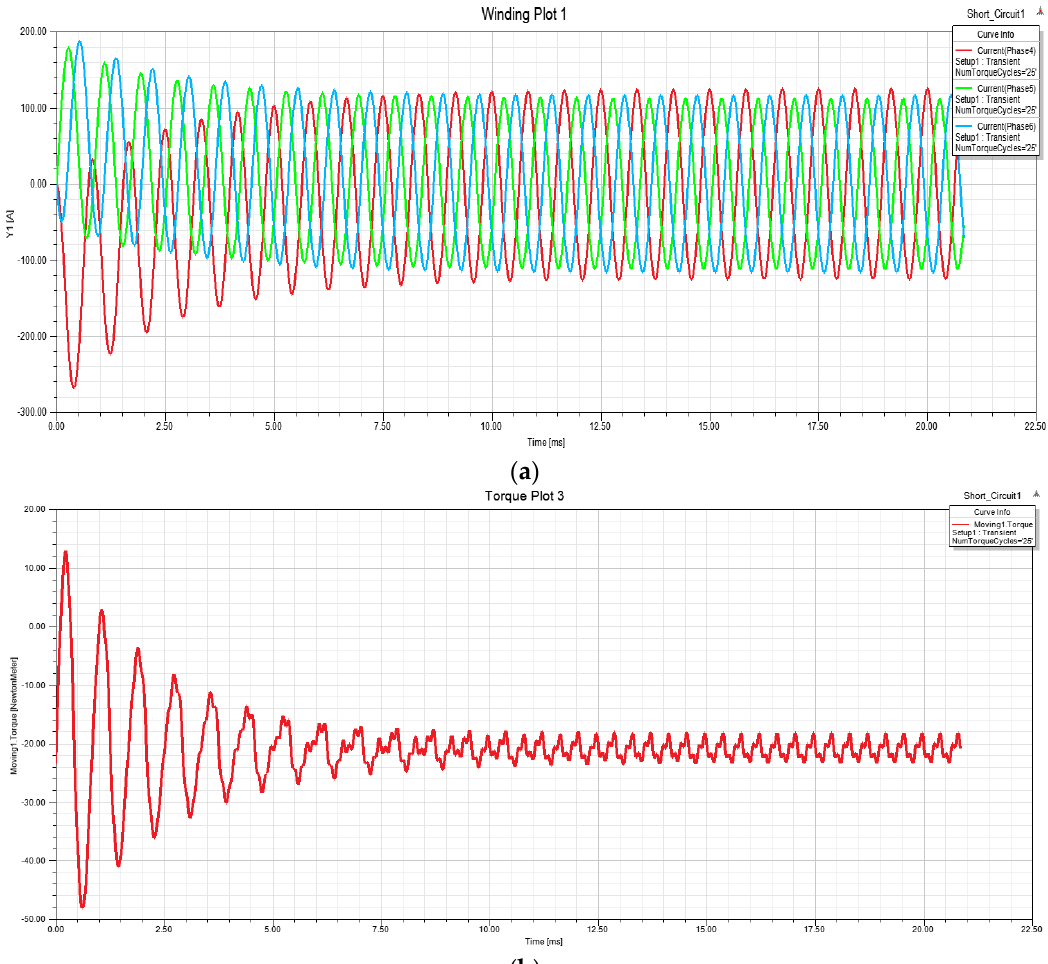
Table 8. The fault tolerance (FT) evaluation of dual three-phase winding.